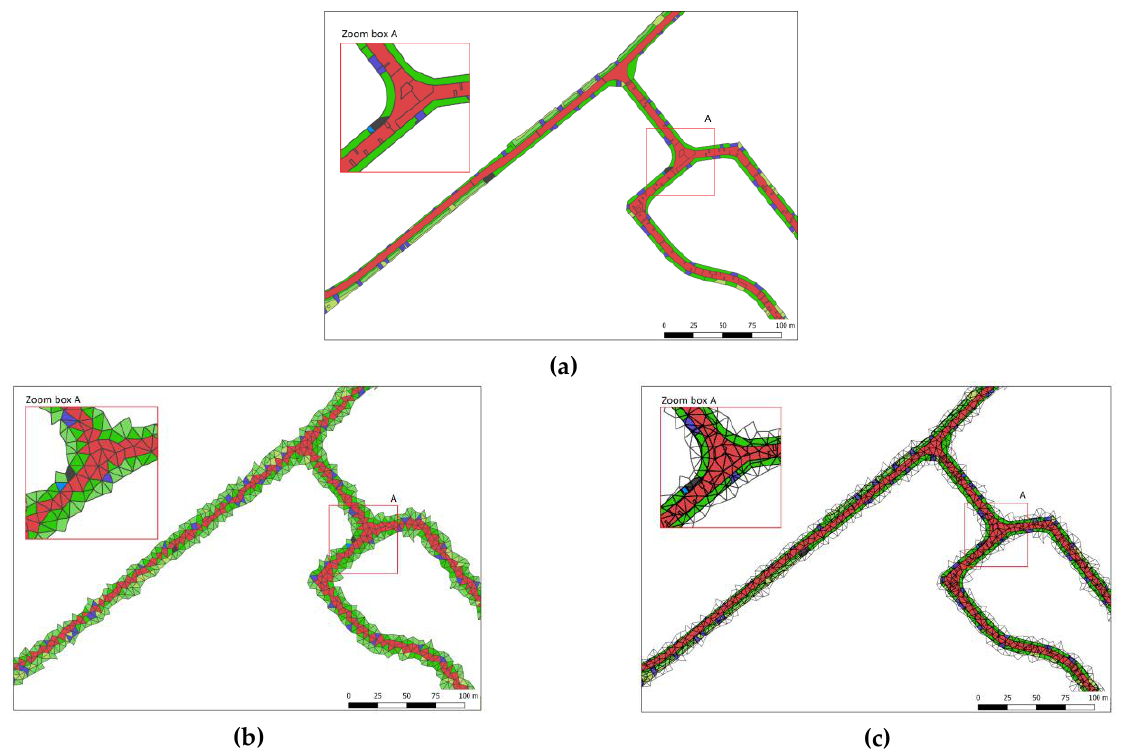
Figure 10. Example of FLIAT approach to compute the impact of floods with a vector approach in which a given road ( a ) has multiple categories and infrastructure elements (e.g., speed bump, intersection, emergency halting-place, traffic lights, etc.). The road is converted to the same unstructured mesh structure of the flood ( b ), while the last figure depicts a situation where every mesh of the unstructured mesh-based flood is split up to the lowest common denominator ( c ).